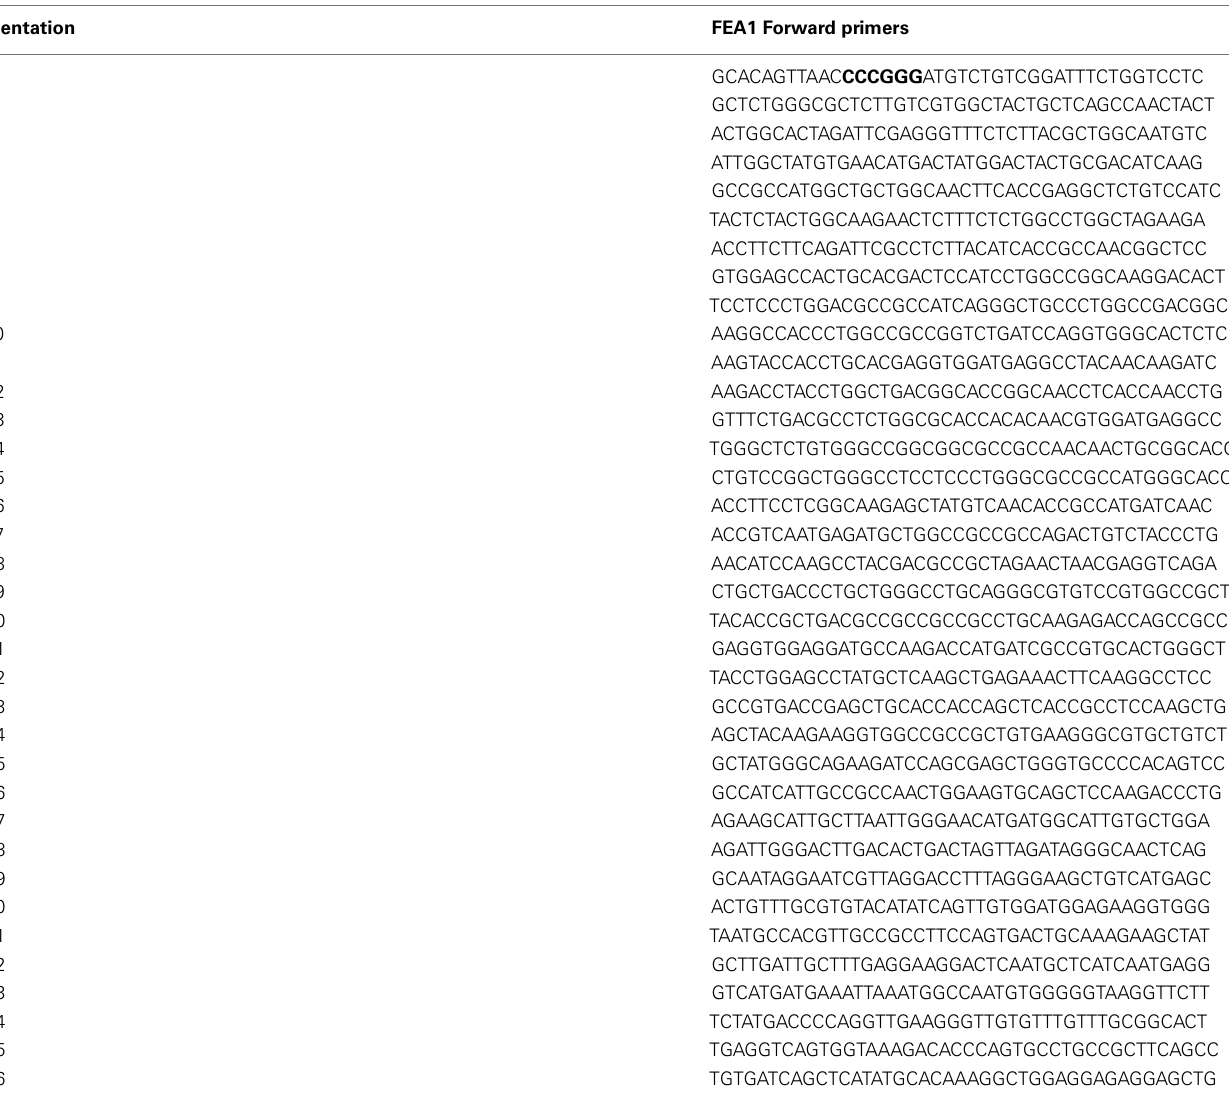
TableA1 | Forward primers for the codon-optimization of Chlamydomonas FEA1 gene for expression in cassava.